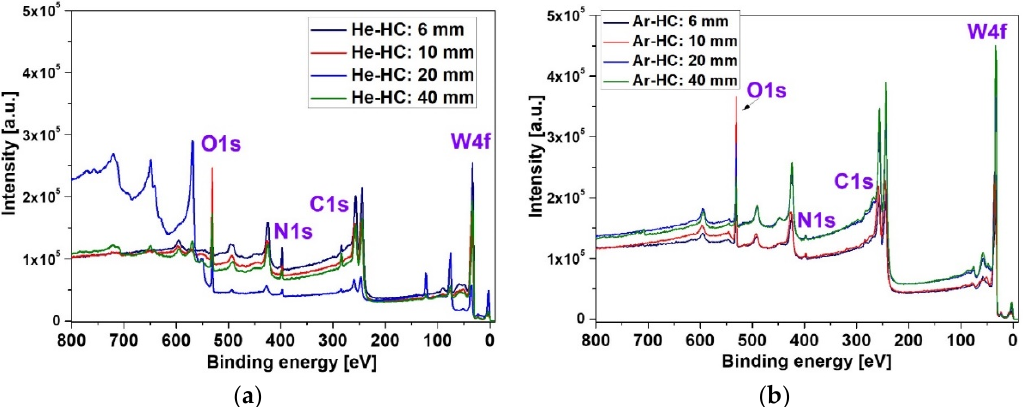
Figure 15. XPS Survey spectra of the obtained particles: ( a ) He-HC configuration; ( b ) Ar-HC configuration. Table 1. Atomic concentrations of the obtained particles in He-HC and Ar-HC. At (%) (He-HC) At (%) Distance